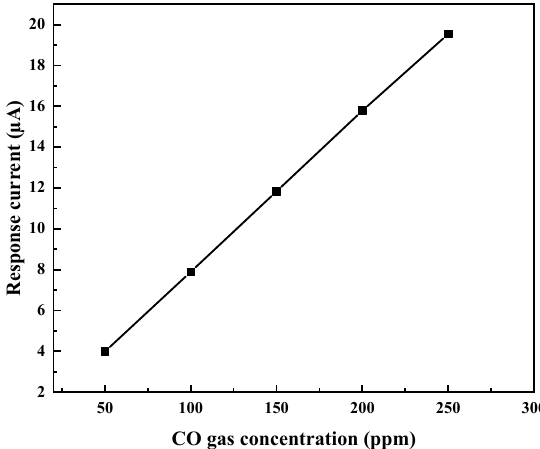
Figure 11. Relationship between the response of sensor and the CO gas concentration.